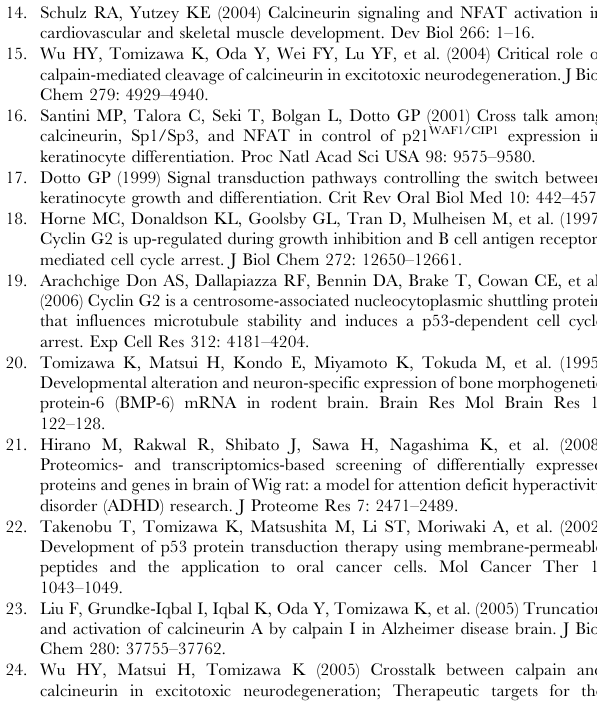
Figure S7 Effect of CnAß-FK overexpression on cyclin G2 expression in Hela cells. HeLa cells were transfected with the CnAß-FK/pcDNA3.1-V5-His vector. The cells were harvest- ed 6, 12 and 24 h after the transfection and the amount of cyclin G2 at each time point was measured by Western blotting. V5 is an epitope tag fused with CnAß-FK.